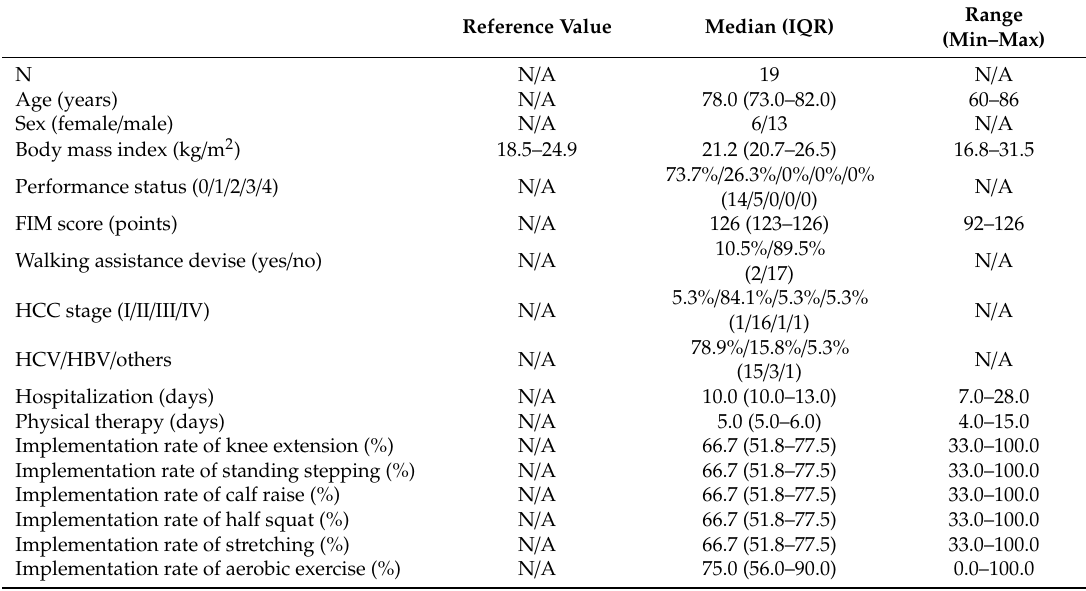
Table 2. Patient